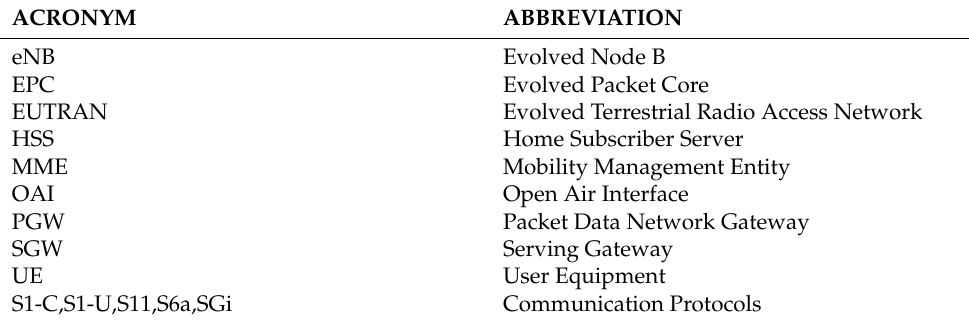
Figure 6. LTE/4G on-premises implementation—high level architecture. In Table 3, we describe the LTE/4G abbreviations. Table 3. 4G/LTE